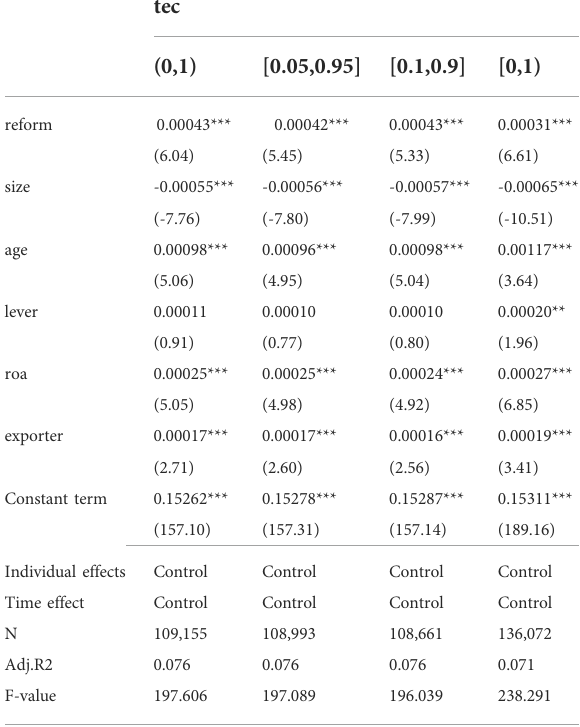
TABLE 3 Mixed ownership reform and technological innovation (benchmark